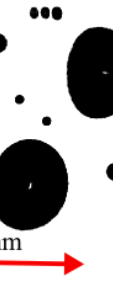
Figure 6. Holographic imagery indicating liquid droplets from pen- etration 1.